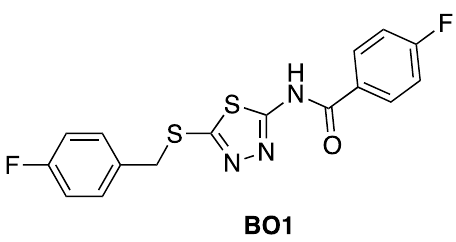
Figure 8. Structure of the ATP competitive/mixed inhibitor of Abl BO1.